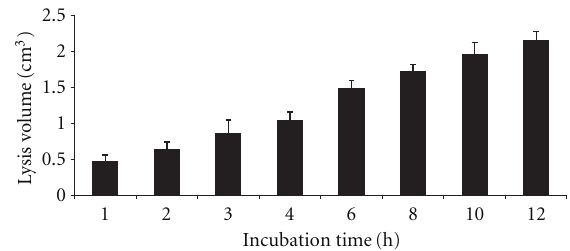
Figure 9: Volume of fibrin lysed by DLBS1033 was calculated at incubation time